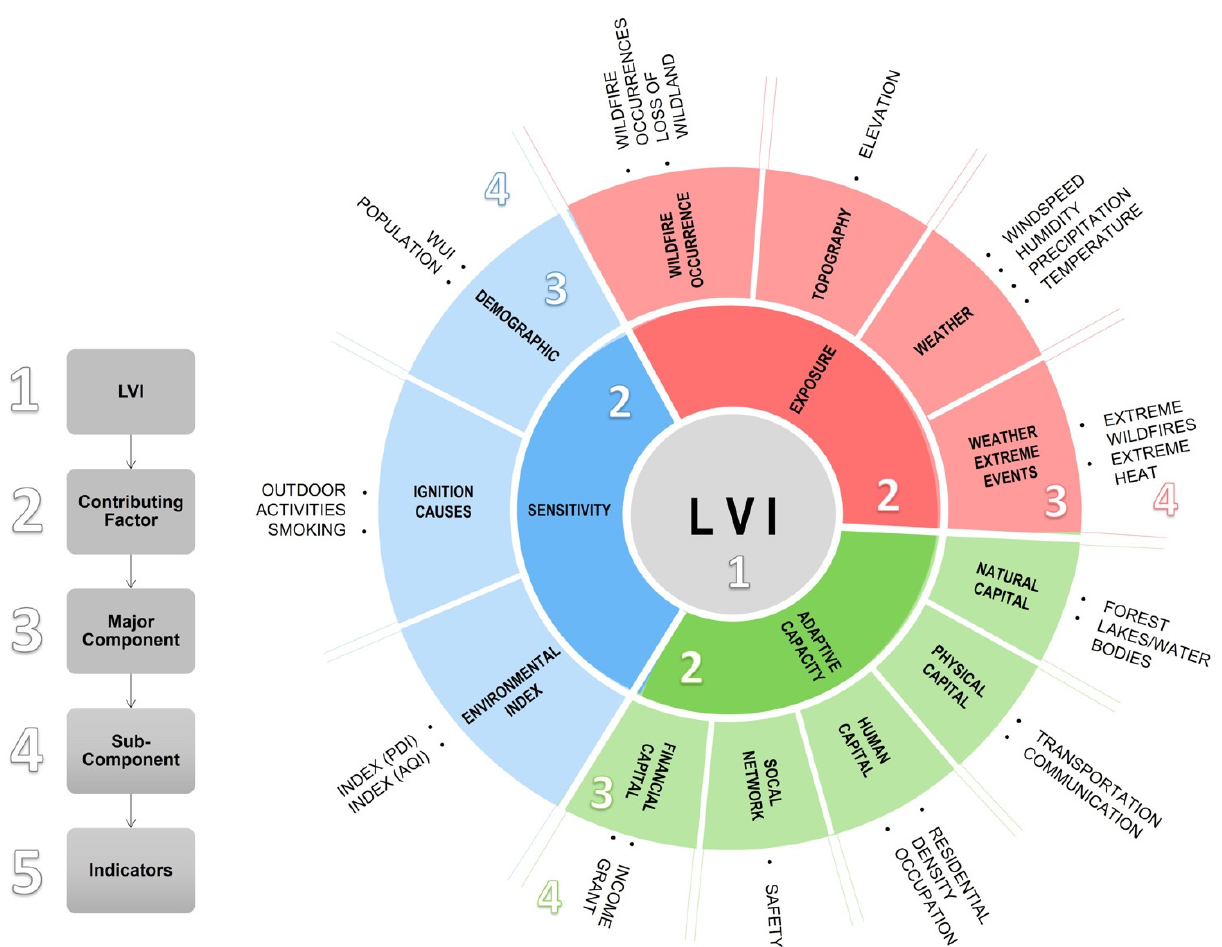
Figure 1. Description of the framework developed for the LVI (box 1 and the central gray circle). LVI is represented by contributing factor (box 2). The contributing factors are sensitivity (blue), exposure (red), and adaptive capacity (green). The contributing factors are further divided into major components (box 3). The major components are color-coordinated with the contributing factors. The major components for sensitivity (blue) are demographic, ignition causes, and environmental index (light blue); for exposure (red) are wildfire occurrence, topography, weather, weather extreme events (light red); for adaptive capacity (green) are social network, natural, physical, human, and financial capital (light green). Major components are divided into sub-components (box 4) and represented by the sub-components in the outermost part of the circle. The sub-components are further divided into indicators (box 5) and not shown in this figure. Refer to Table A2 for each indicator variable.